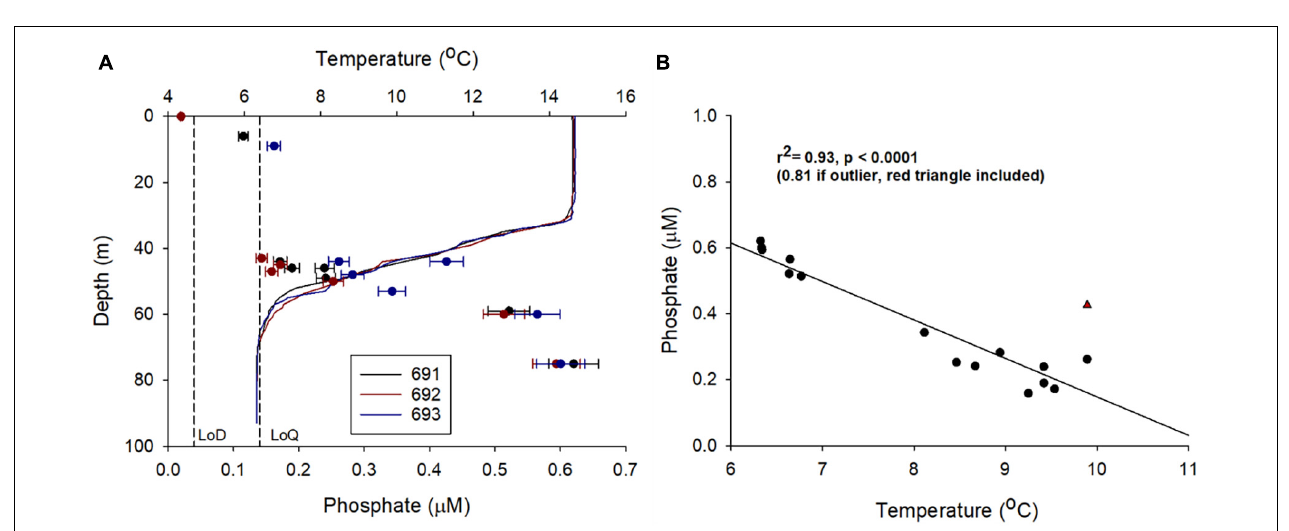
FIGURE 8 | (A) The relationship between phosphate and temperature for the entire dataset. (B) An example depth profile of phosphate and temperature (dive number 883 conducted on 23/08/2018).